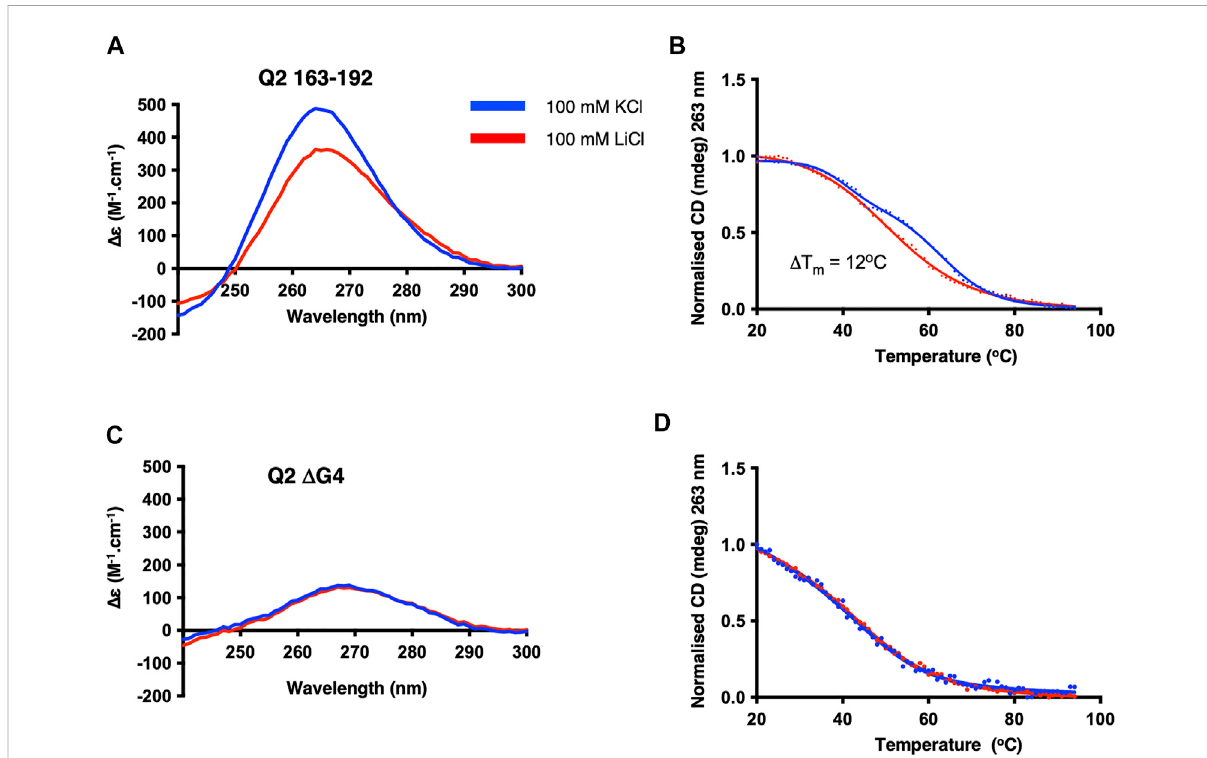
FIGURE 6 CD structural characterisation of Q2 163 – 192 and Δ G4 RNA in the presence of HeLa nuclear extract. CD at 20 C and thermal melting curves of Q2 RNA (A,B) and Δ G4 RNA (C,D) . Experiments were conducted in 10 mM TBA buffer pH 7.0, 5% HeLa nuclear extract, and either 100 mM KCl (blue) or LiCl (red) in a 1 mm pathlength quartz